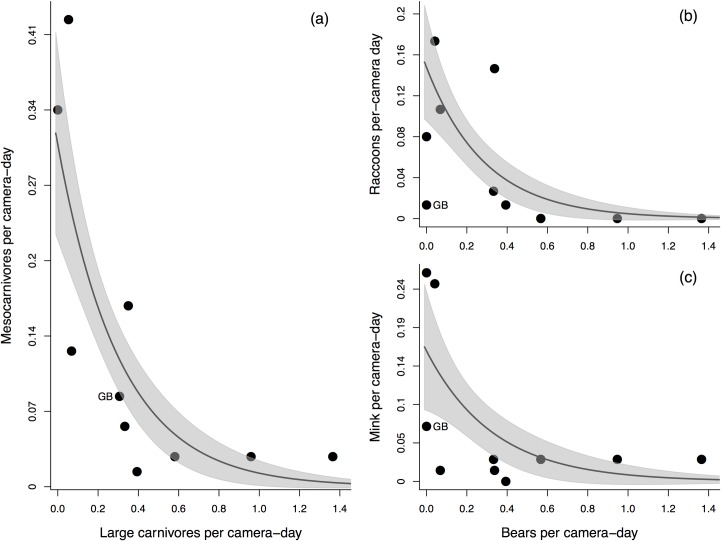
Relationship between large carnivore relative abundance and mesocarnivore relative abundance across ten study sites in Clayoquot, as determined by camera traps.Plots show the relative abundances (i.e., individuals per camera-day) of (a) all large carnivores and all mesocarnivores, (b) bears and raccoons, and (c) bears and mink. Lines represent Poisson GLM estimates of the relationship between mesocarnivore and large carnivore relative abundance, and shaded areas denote standard errors of model estimates. Grice Bay (GB) is indicated in all plots. Grice Bay showed exceptionally high levels of wolf activity and was excluded from the GLM analyses performed on data presented in (b) and (c) (see Methods for details).